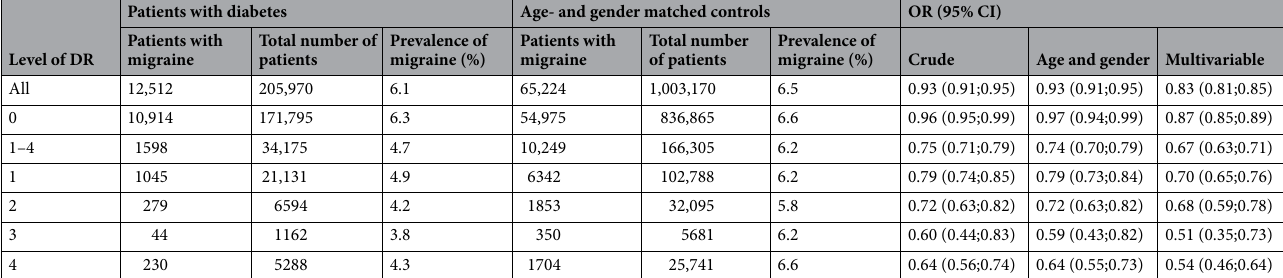
Table 1. Prevalent migraine in patients with diabetes according to level of diabetic retinopathy and their corresponding age- and gender-matched controls. Odds ratio (OR) with 95% confidence interval (CI) for prevalent migraine for patients with diabetes mellitus screened for diabetic retinopathy (DR) (cases) compared to age- and gender-matched controls (1:5) according to level of DR for cases at the time of the first registration in the Danish Registry of Diabetic Retinopathy for cases. CI confidence interval. Level of DR given by the worse eye. Multivariable model adjusted for sex, age, marital status, use of lipid lowering drugs and Charlson comorbidity index: myocardial infarct, congestive heart failure, cerebrovascular disease, chronic pulmonary disease, connective tissue disease/rheumatologic disease, ulcer disease, mild liver disease, hemiplegia/ hemiplegia or paraplegia, any malignancy (including leukemia and lymphoma), moderate-severe liver disease, solid metastatic tumor, and acquired immunodeficiency